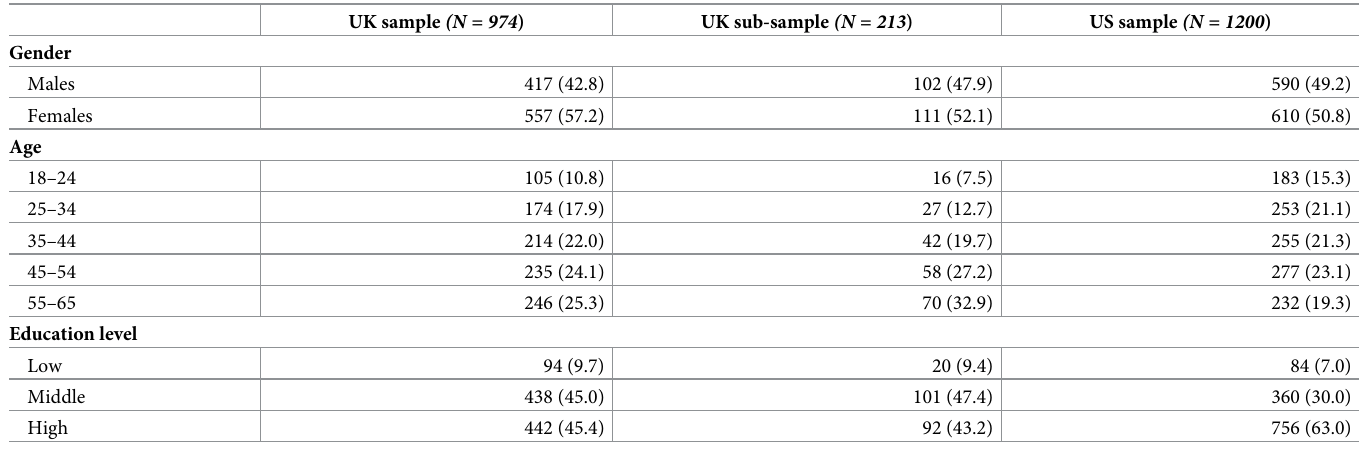
Table 1. Overview of sample